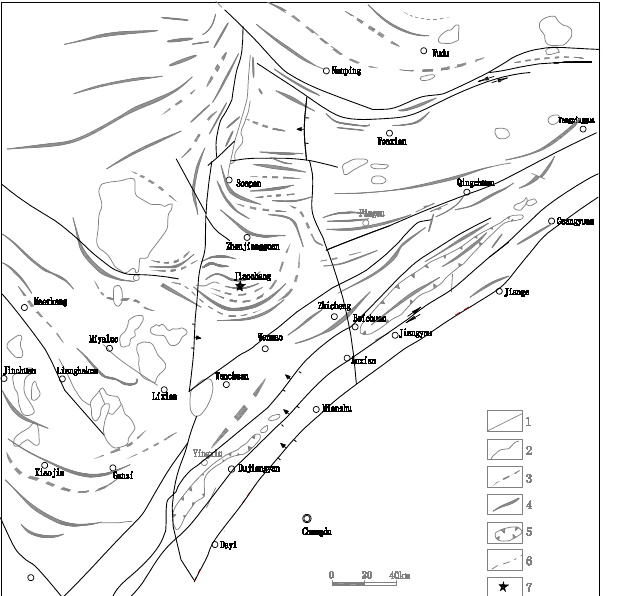
Figure 1. Regional geology.